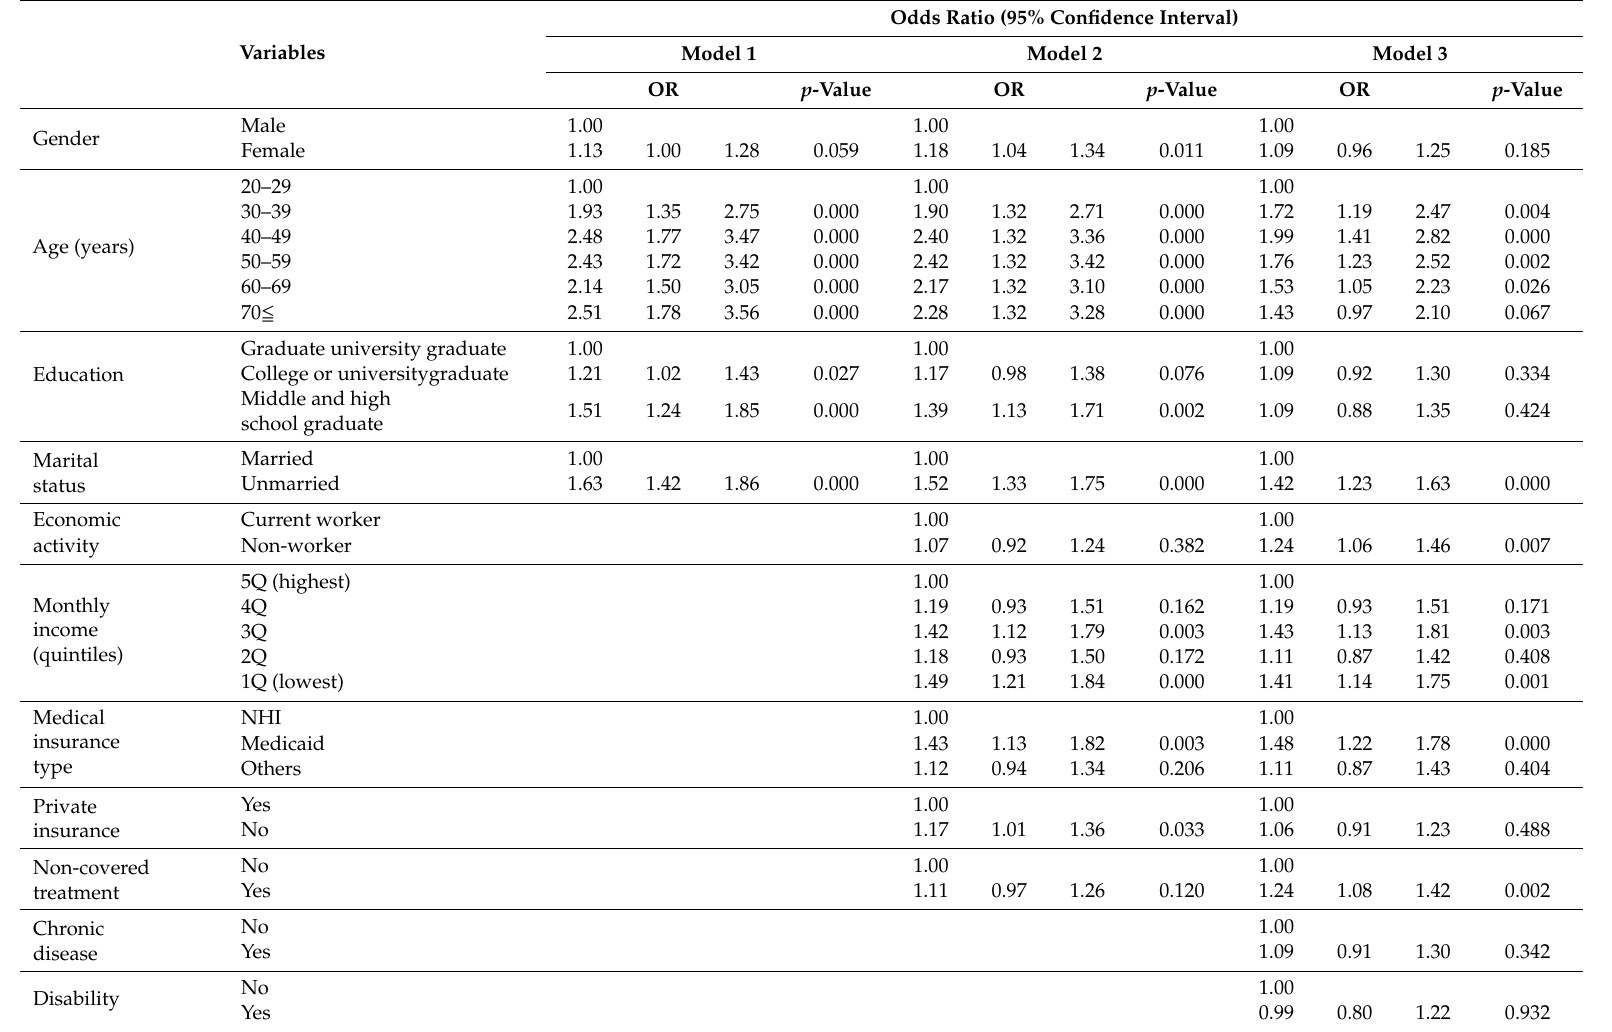
Table 3. Regression analysis of the factors related to unmet medical